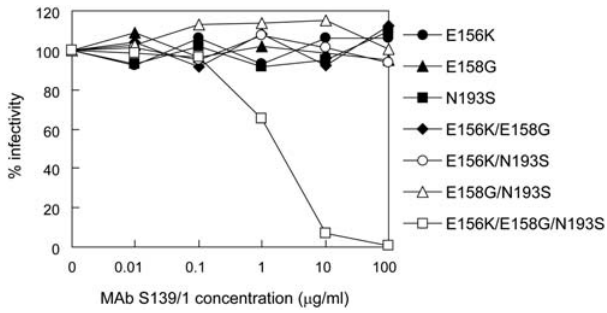
Figure 6. Neutralizing activity of MAb S139/1 to PR8 mutants with altered epitopes. Amino acids at positions 156, 158, and/or 193 of PR8 HA were substituted for by those at corresponding positions of the Aichi HA sequence. Other experimental conditions were described in Materials and Methods.